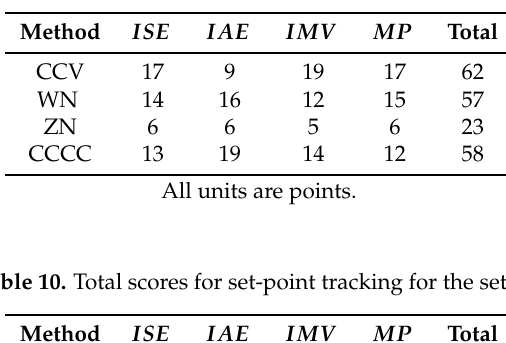
Table 10. Total scores for set-point tracking for the set P 4 .